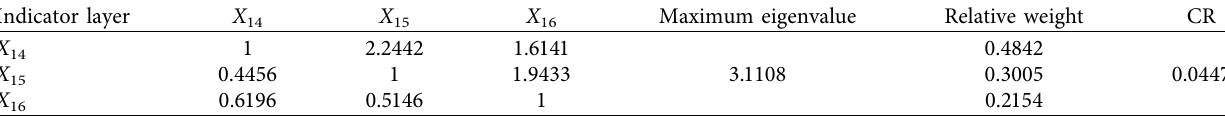
Table 13: Judgment matrix and weights of indicator layer indices in criterion B